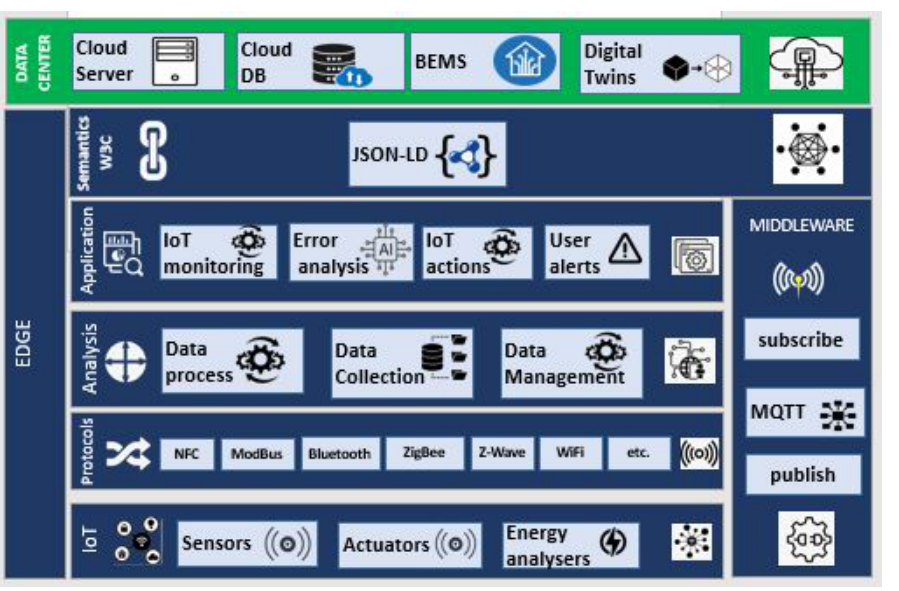
Figure 2. SEDGE conceptual